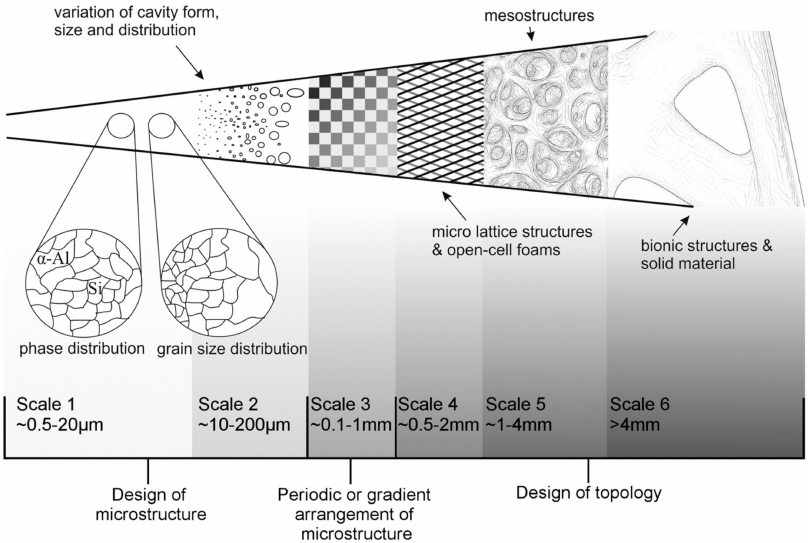
Figure 1. Proposed levels of influence to create a Designed Material. Based on these approaches, a material can be designed and optimized for a specific purpose or